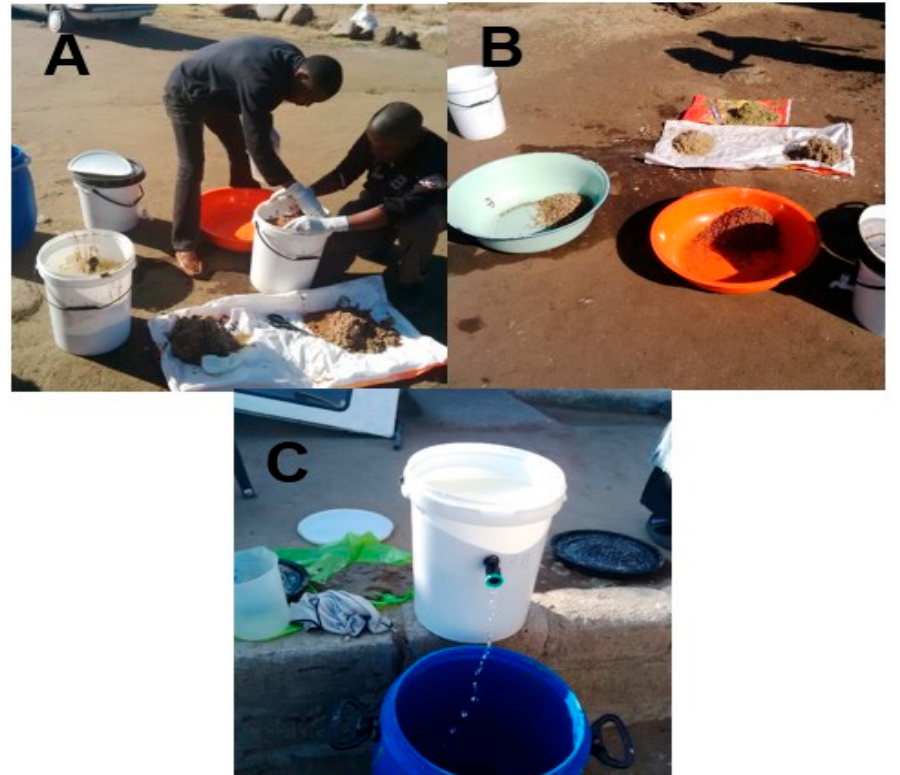
Figure 3. Maintenance of the BSZ-SICG filter implemented in Makwane Village. ( A ) Training of one of the householders on how to wash the layers of the BSZ-SICG filter; ( B ) all five layers after being washed (gravel, coarse sand, fine sand, natural zeolite, and silver-impregnated clay granules); and ( C ) filtered water after the washing of the BSZ-SICG filters.